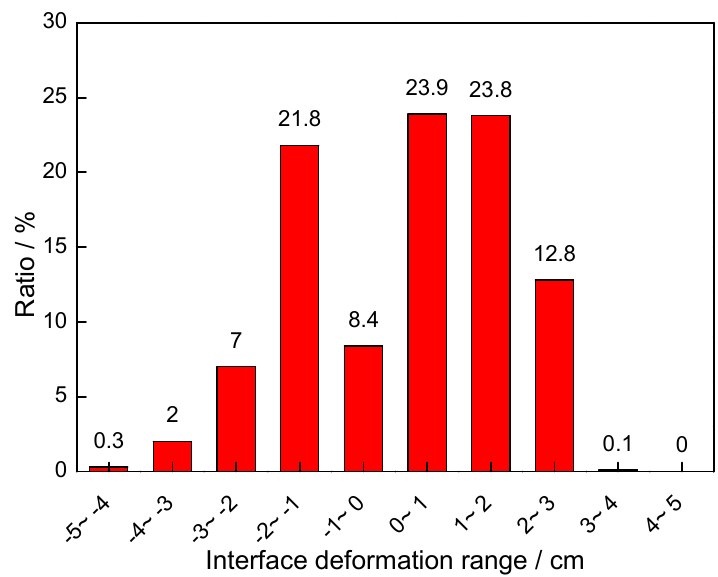
Figure 4. Interface deformation range distribution of reference state.